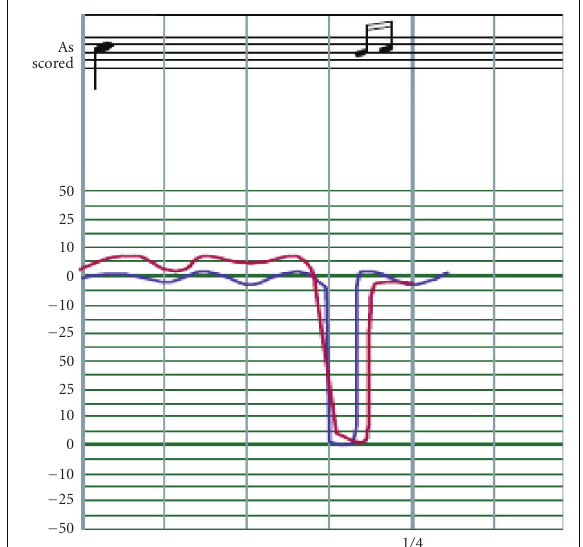
Figure 2: Comparing ornamentation and intonation between the player and that of Jean-Pierre